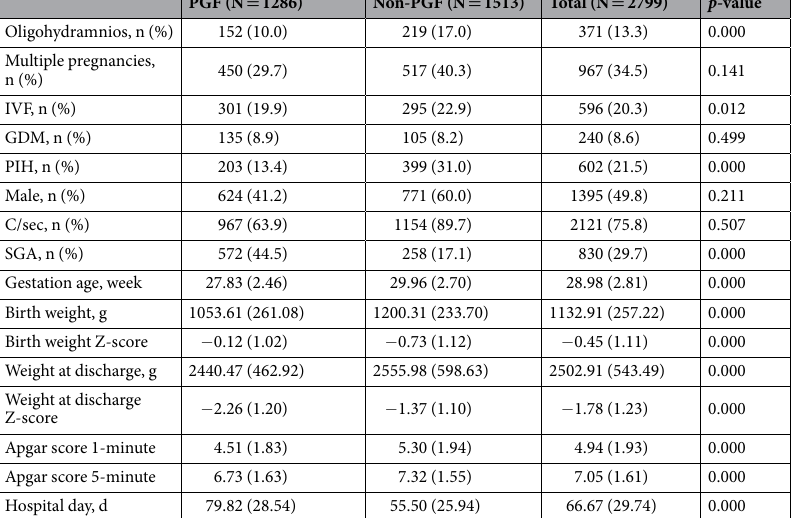
PGF (N = 1286) Non-PGF (N = 1513) p- value RDS, n (%) 1143 (88.9)